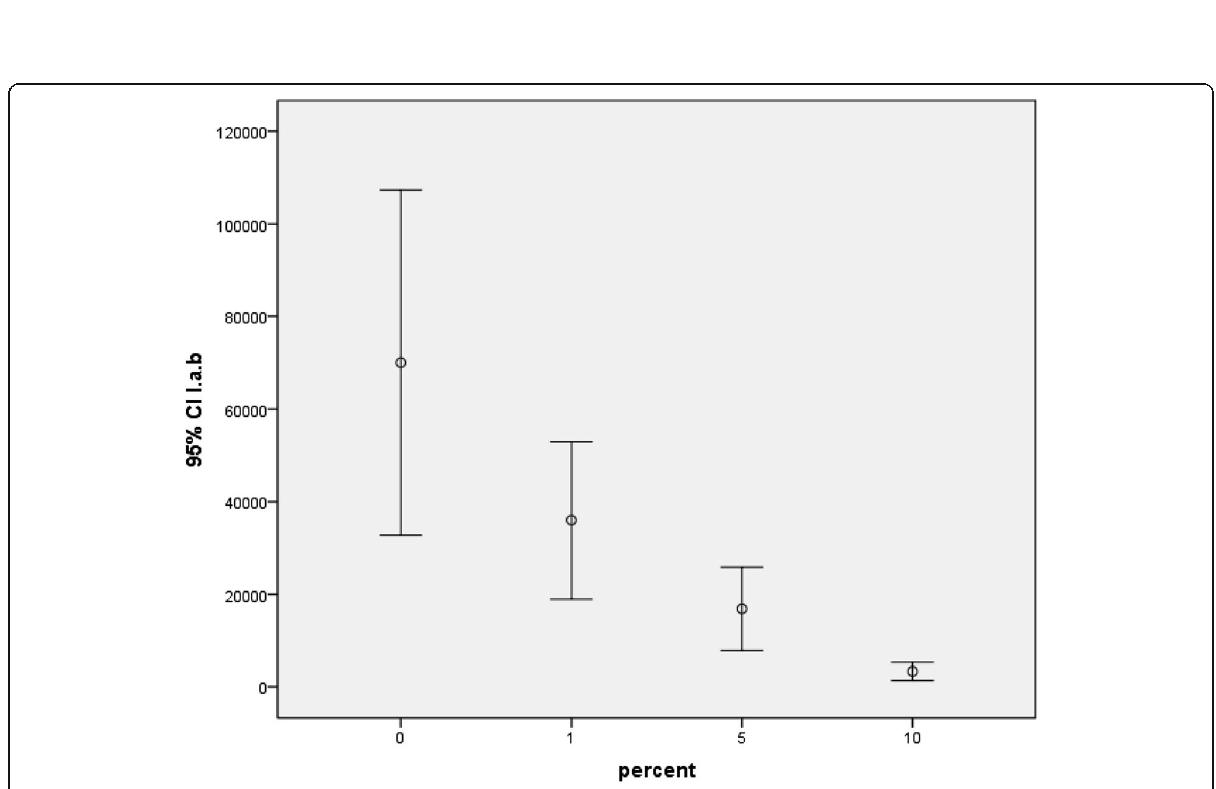
Fig. 5 Viable counts of L. acidophilus biofilms on composite discs containing 0, 1, 5, and 10 % Ag/HA